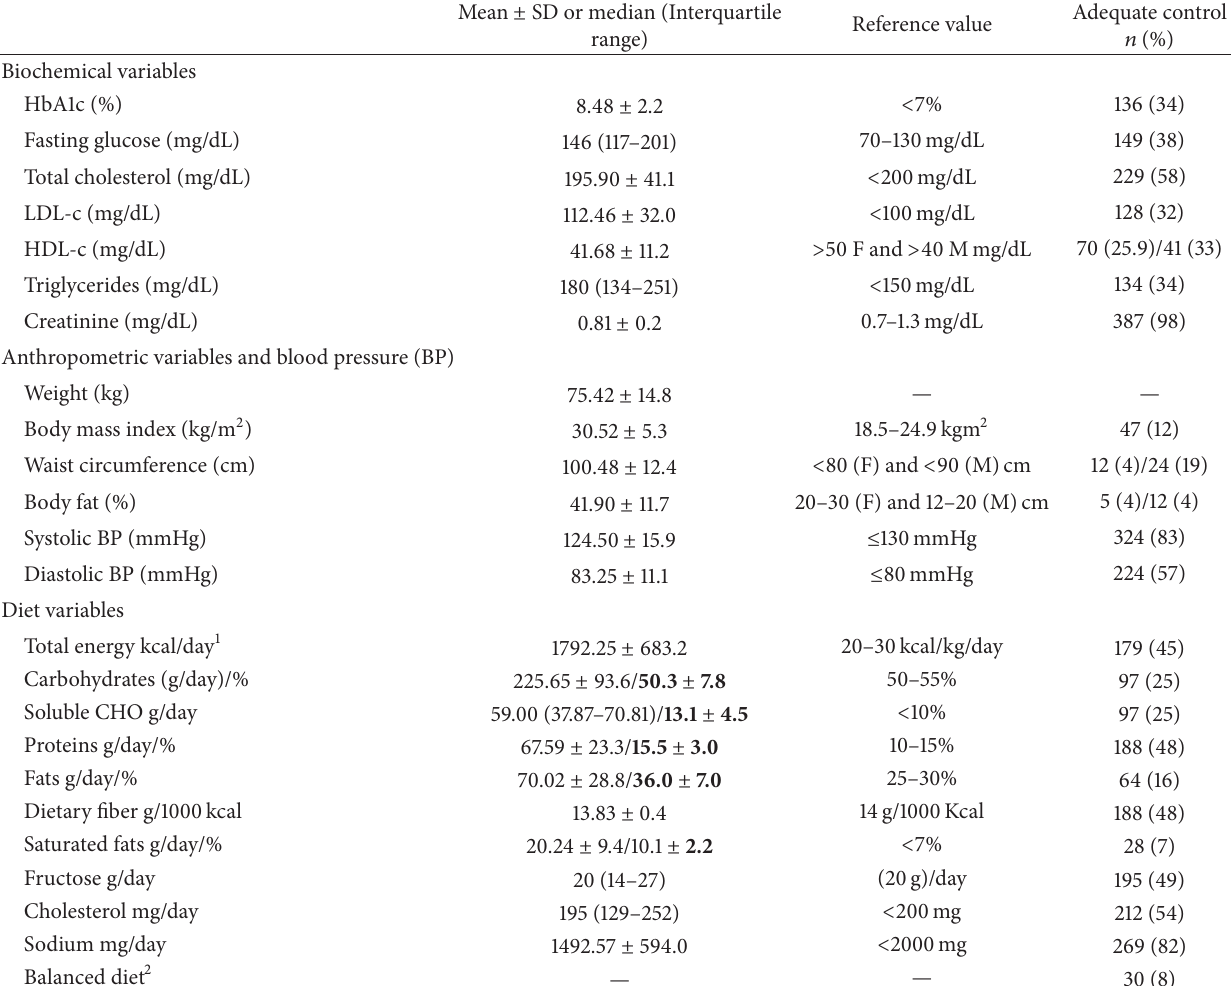
Table 2: Metabolic control and diet characteristics of the studied population ( 𝑛 = 395